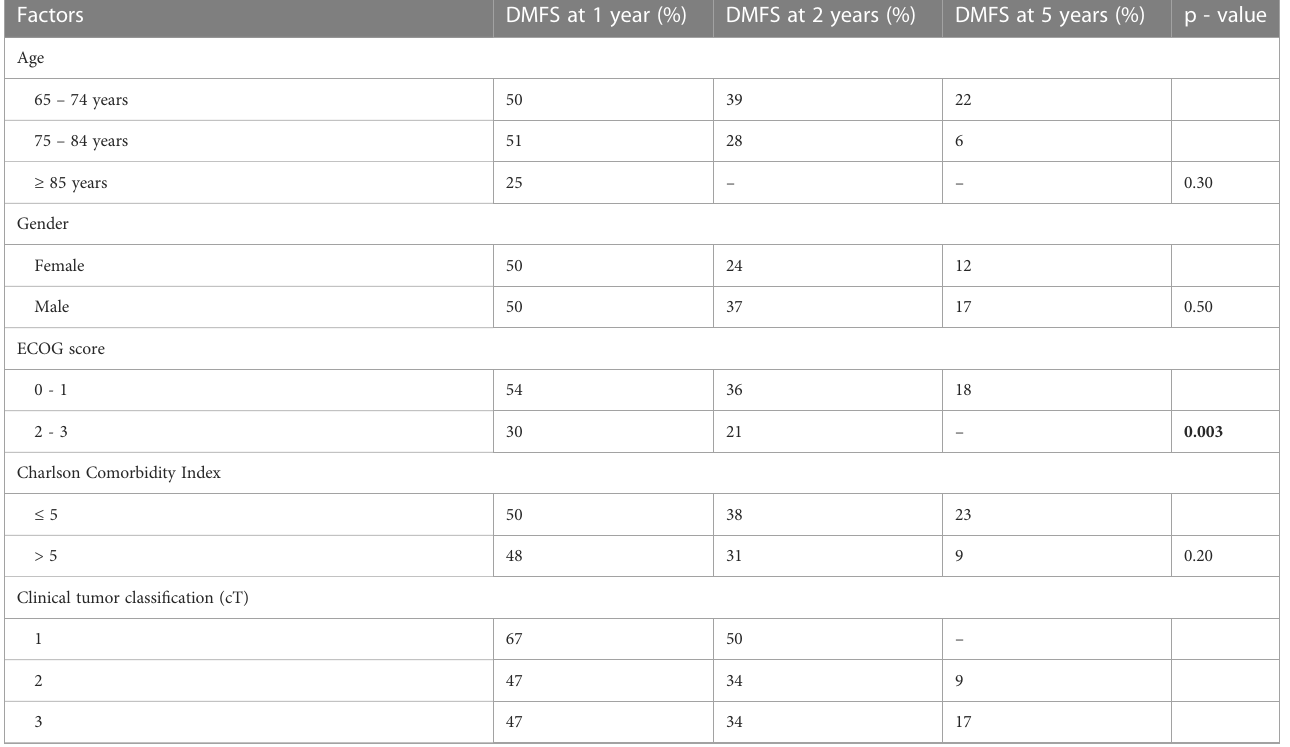
TABLE 2C Univariate analyses of potential prognostic factors for distant metastasis-free survival (DMFS).